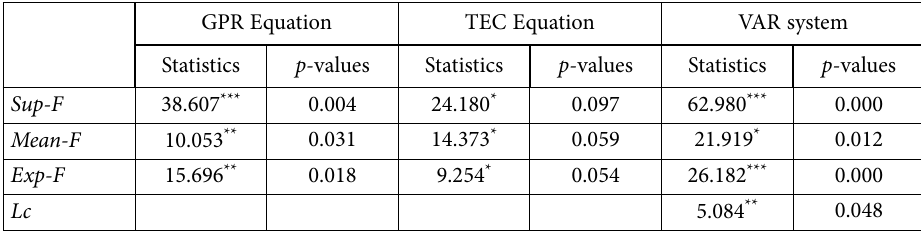
Table 4. The parameter stability